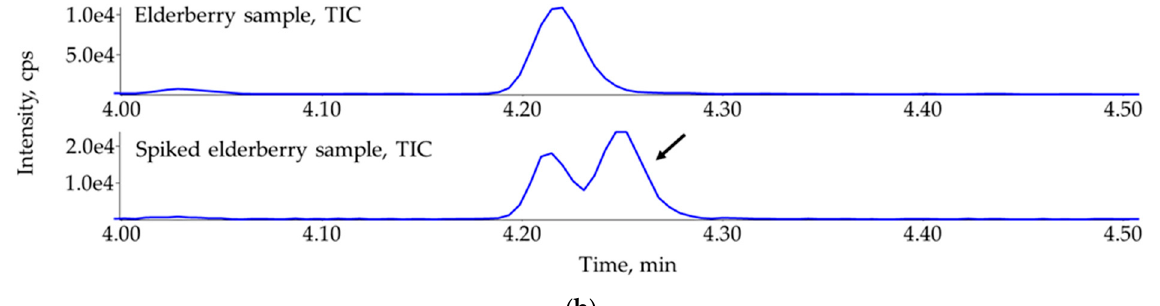
Figure 4. ( a ) Screening analysis of propham in an elderberry sample. Relevant signals in the expected retention time (7.80 min) with tolerable IR difference appeared on the ion transitions of m / z 180 > 138 and m / z 180 > 120. ( b ) Confirmatory analysis of propham in elderberry sample. The retention time difference between the target compound (indicated by the arrow at 4.25 min) and the interfering matrix peak (4.21 min) can be clearly observed with the help of the standard addition process (below).